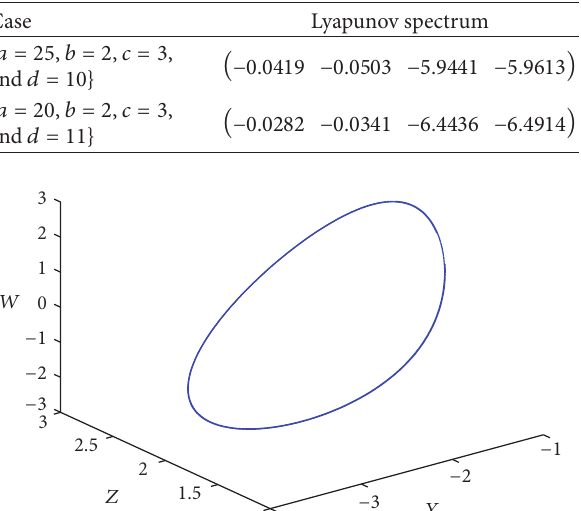
Table 2: Lyapunov spectrum at the bifurcation points.